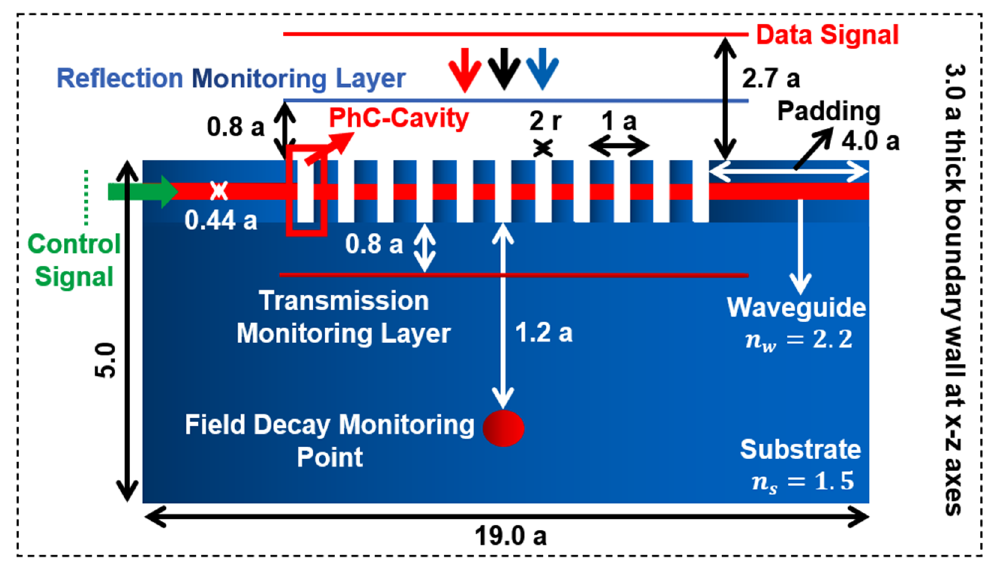
Figure 3. The structure of the optical switch reflecting the details of the parameters used.